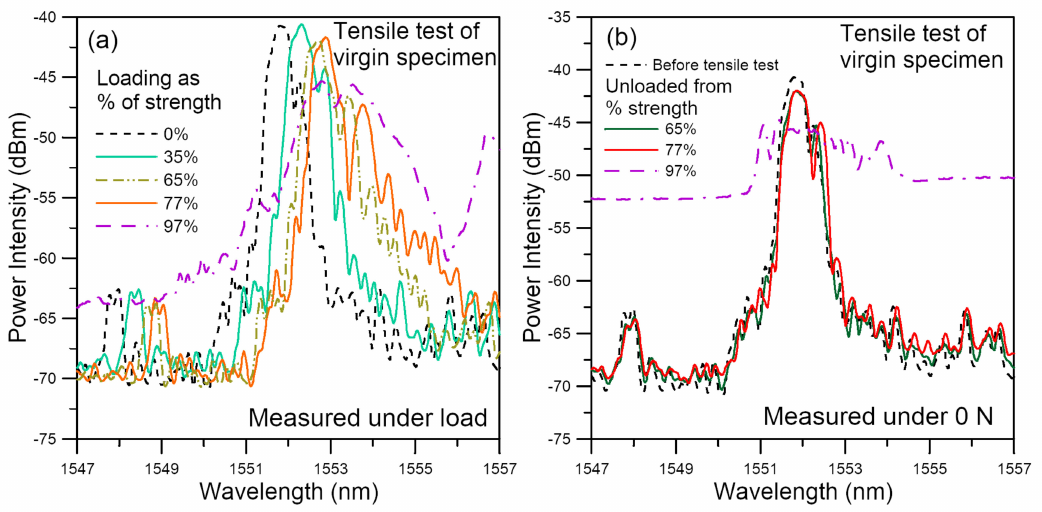
Figure 9. Evolution of virgin specimen spectra under tension measured ( a ) at various loads; ( b ) at 0 N after unloading from various tensile